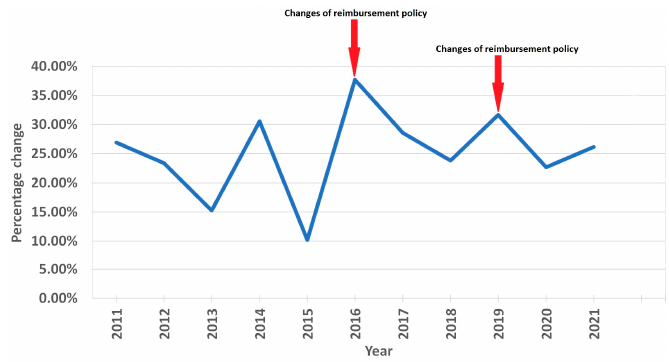
Figure 8. Annual percentage change in statin sales and changes in national reimbursement policies.